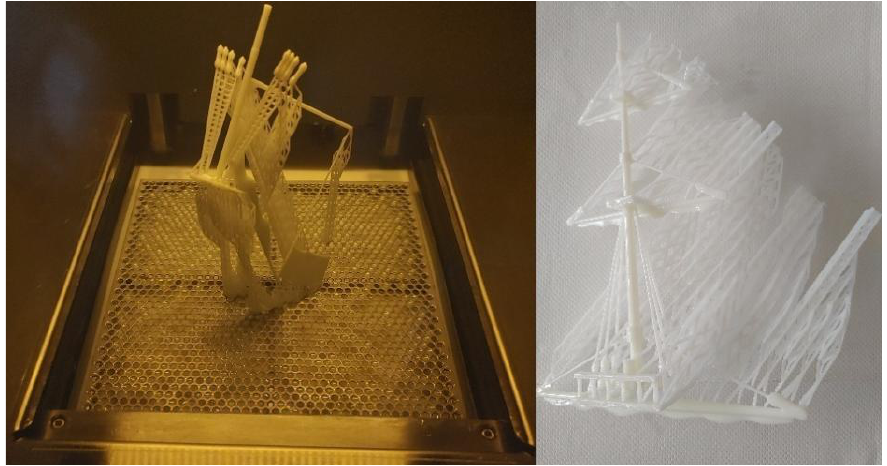
Figure 21 . Left — printing process; right — 3D-printed product. Figure 21. Left—printing process; right—3D-printed